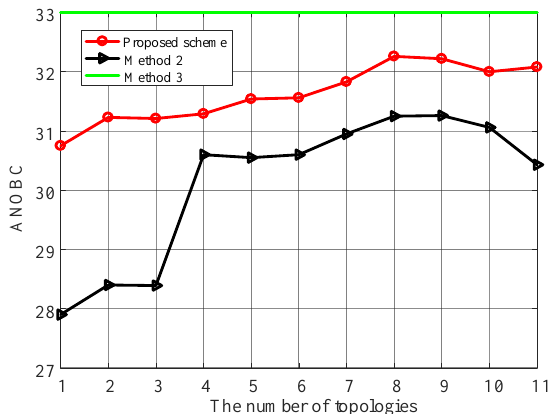
Figure 8. Relationship between N D-PMU and the number of topologies.